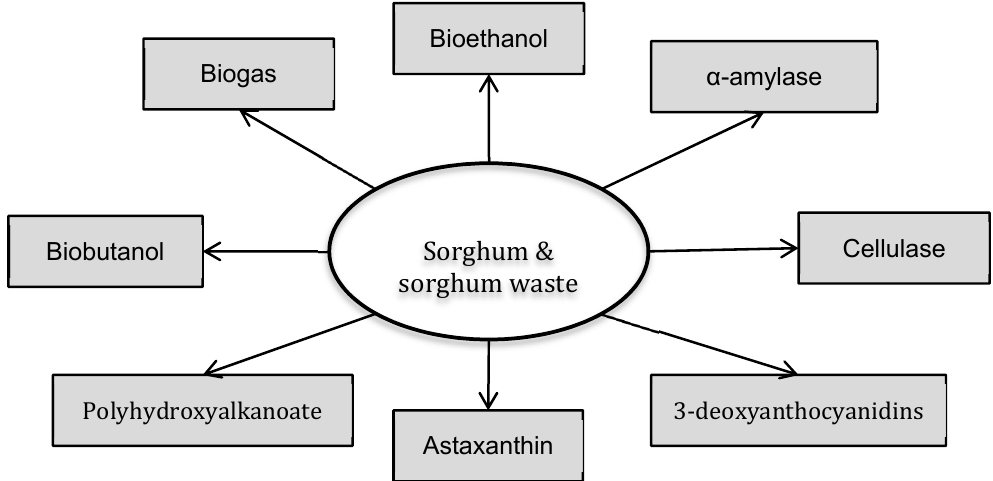
Figure 1. The schematic diagram showing the potential food ingredient and non-food products that can be derived from sorghum and sorghum waste. Table 1. Recent studies on glucoamylase production via fungal fermentation. Substrate Strain